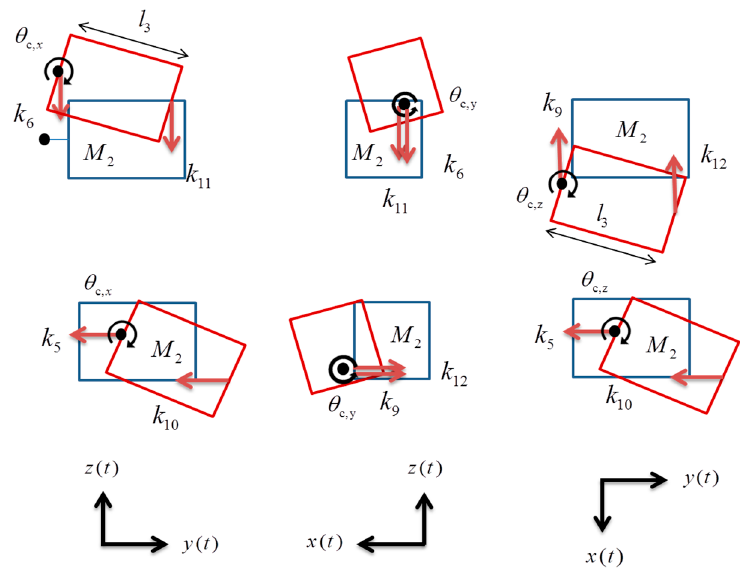
Figure 3. Free-body diagrams of the aiming unit.